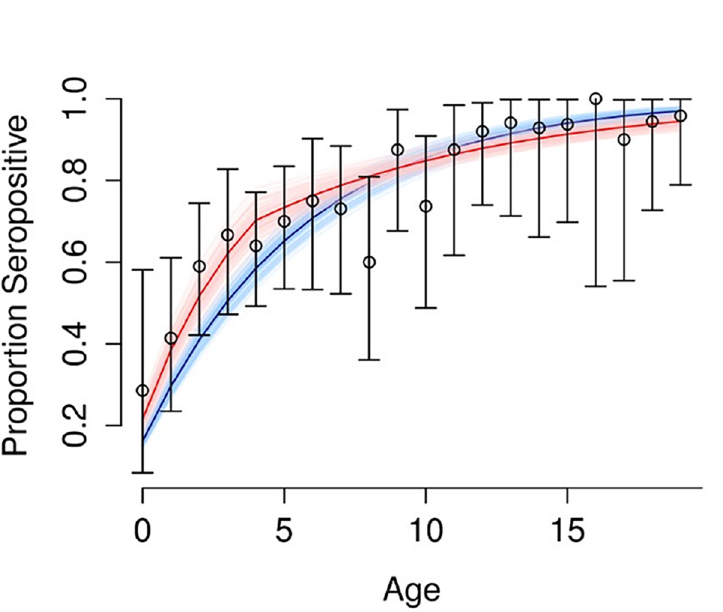
Fig 5. Proportion of subjects of different ages that were dengue seropositive at enrolment (shown in black). Fit of model 1 assumed constant force of infection (shown in blue). Fit of model 2 assumed non- constant force of infection (shown in